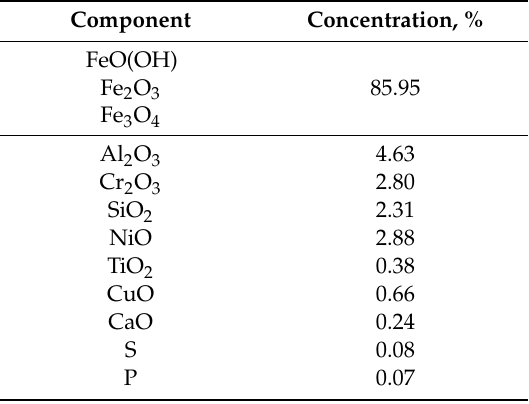
Table 1. Chemical composition of